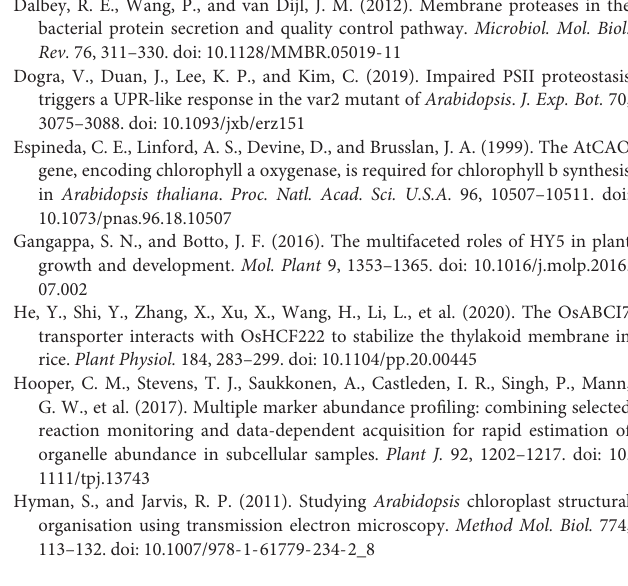
Supplementary Table 1 | List of primers used in this study. Supplementary Table 2 | MS/MS spectrum database search analysis summary. Supplementary Table 3 | Summary of number of differentially expressed proteins for each